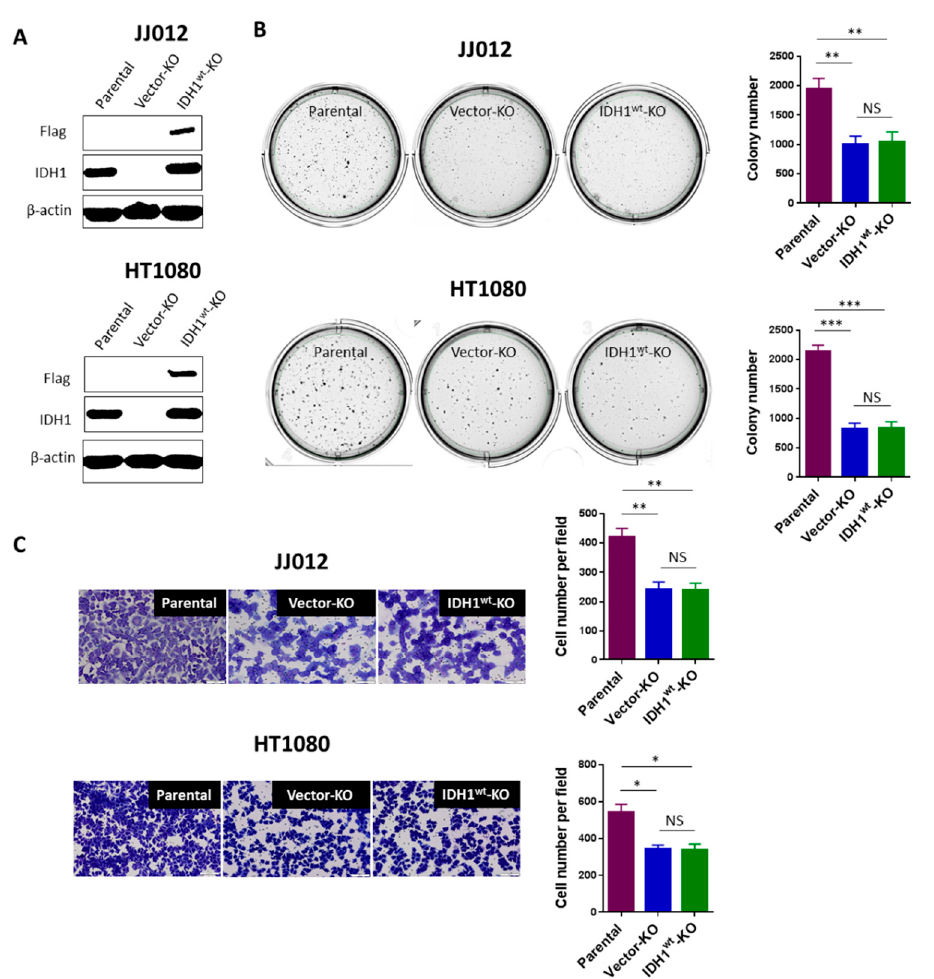
Figure 3. Loss of IDH1 wt is dispensable for the attenuated tumorigenicity of chondrosarcoma cells. ( A ) Immunoblot shows high levels of exogenous IDH1 (Flag) in the IDH1 KO cells from both cell lines. ( B , C ) Re-expression of IDH1 wt did not alter the decrease in colony formation or cell migration of the IDH1 KO cells. Histograms show mean ± SEM of triplicate cultures and are representative of 3 independent experiments. Original magnification, × 20 (scale bars: 100 µ m). * p < 0.05, ** p < 0.01, *** p < 0.001.